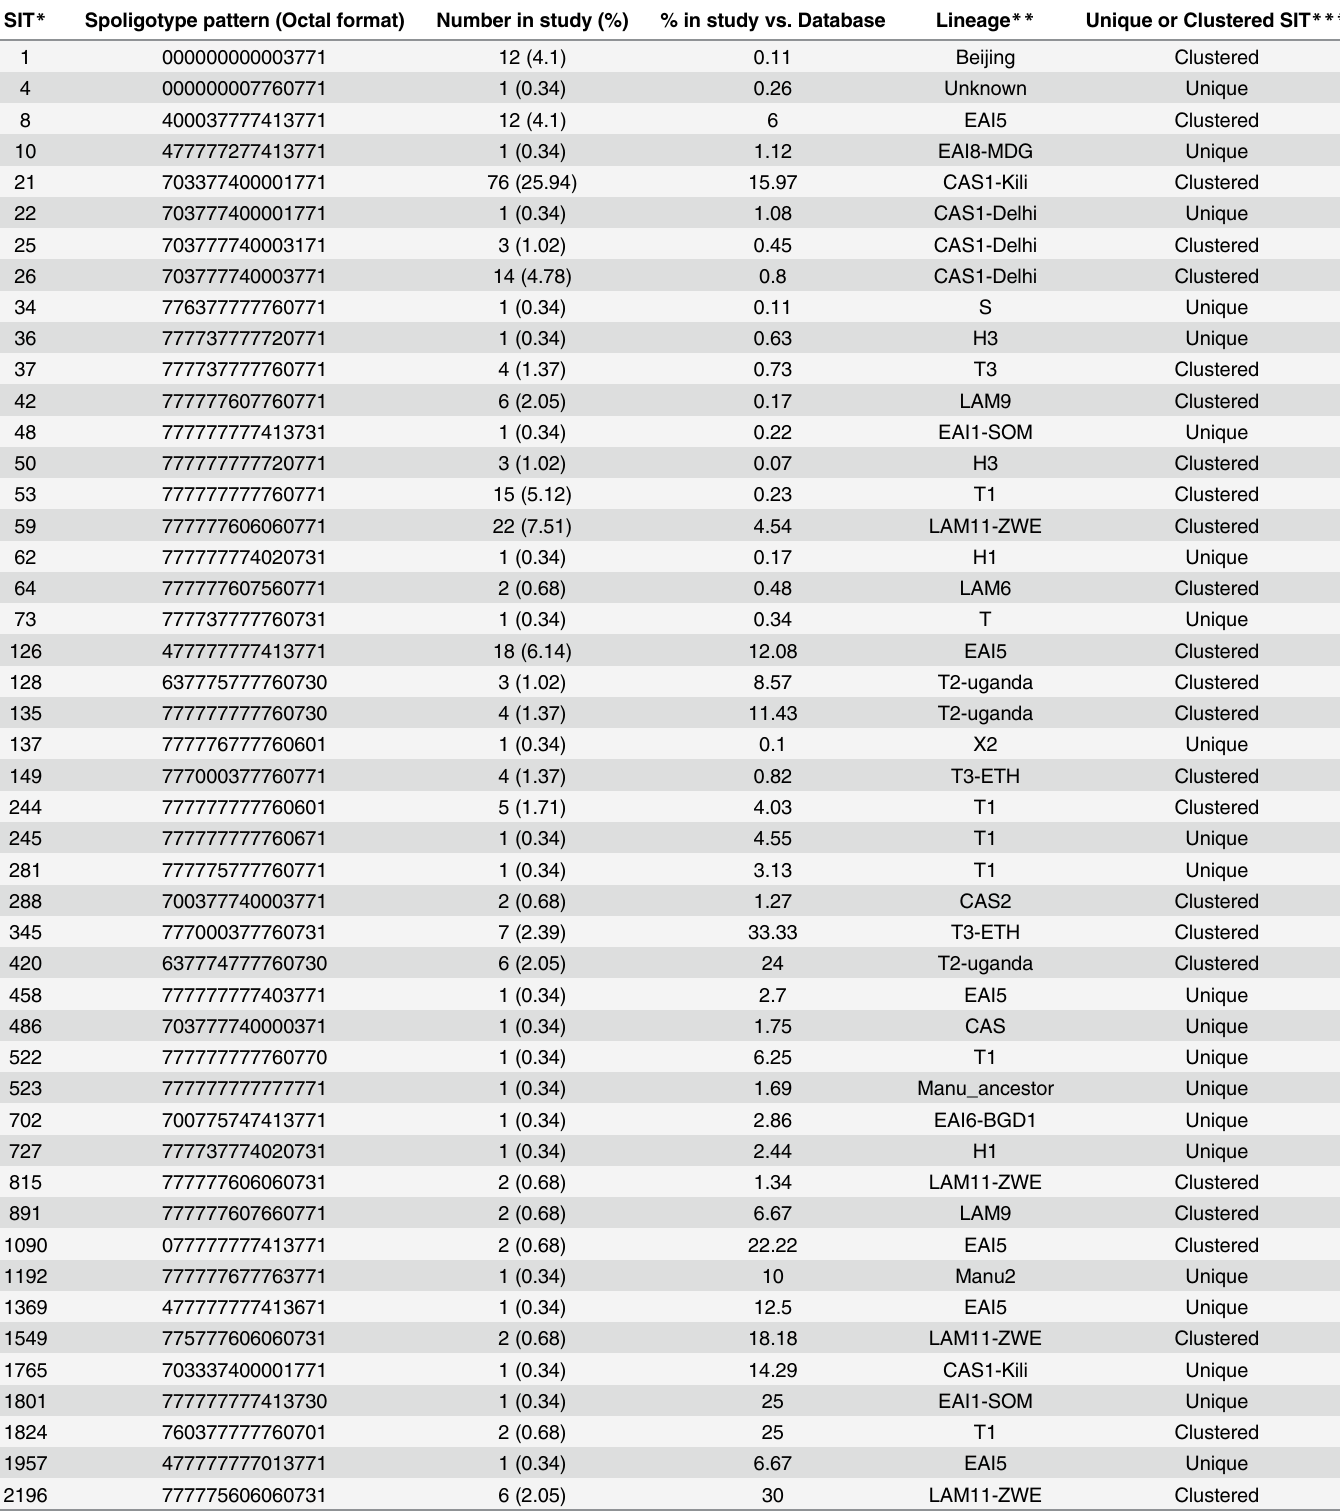
Table 3. Distribution of Spoligotype International Types (SIT) in this